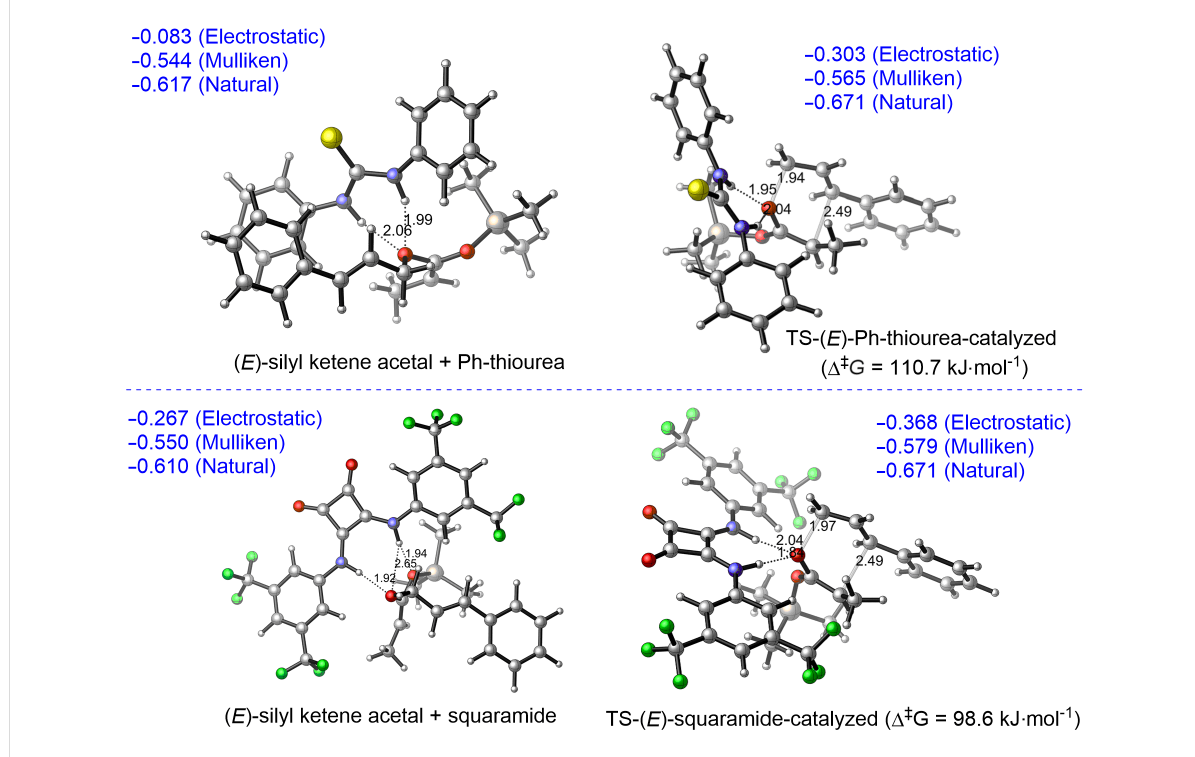
Figure 4: ω B97X-D/6-31G* calculated Ph-thiourea (top) and squaramide-catalyzed (bottom) Ireland–Claisen rearrangement of 1c . Charges on allylic oxygen (blue); C–O bond-breaking and C–C bond-forming distances in TS (black); hydrogen-bond distances (black).